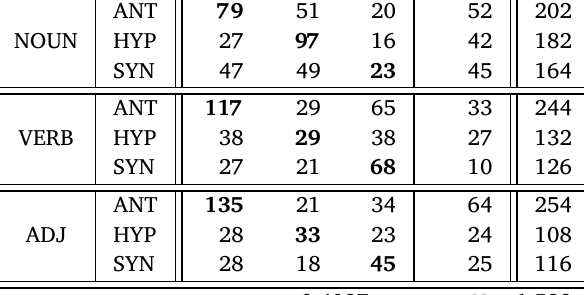
Confusion matrix for class assignment using frequency-based pattern features (with